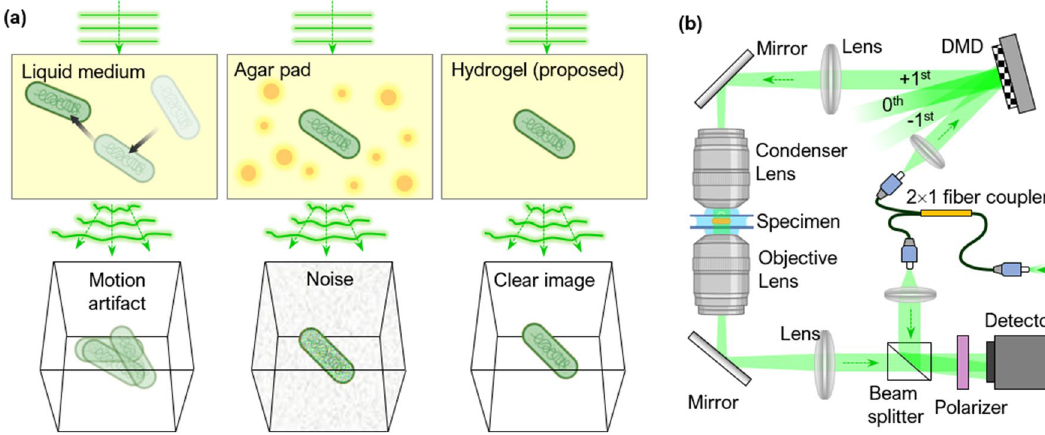
Figure 1. ( a ) QPI measurements of bacteria in different environments. The image quality is reduced by bacterial motility and background noise in a liquid medium and agar pad, respectively. A hydrogel-based environment prevents both issues. ( b ) Schematic of the ODT system. DMD: digital micromirror device.